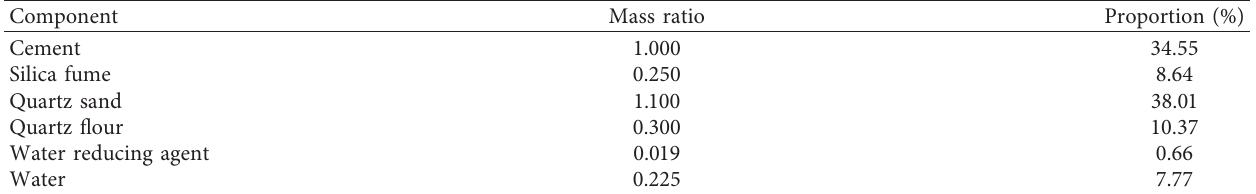
Table 2: Mix proportion of UHPC (Table 2 is reproduced from “Study on the Static Performance of Prefabricated UHPC-Steel Epoxy Bonding Interface”).